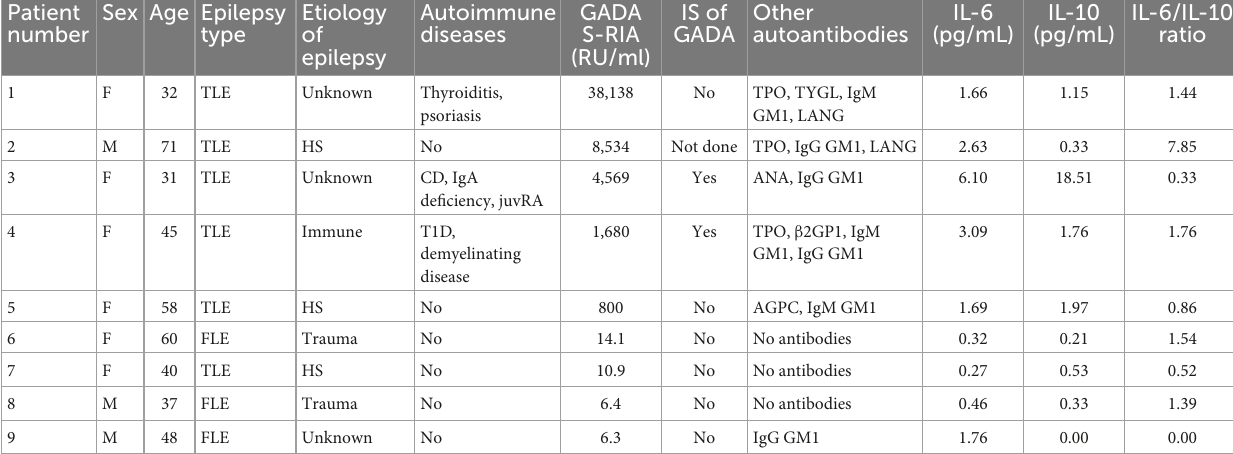
TABLE 2 Clinical characteristics and median cytokine levels of GADA positive patients. Patient Sex Age Epilepsy number type